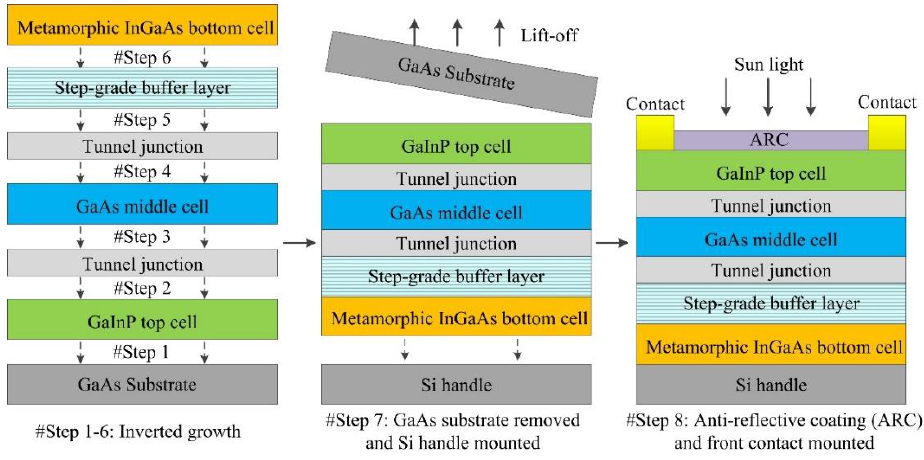
Figure 1. Schematic of the epitaxial growth process of the IMM3J GaInP/GaAs/InGaAs solar cell.